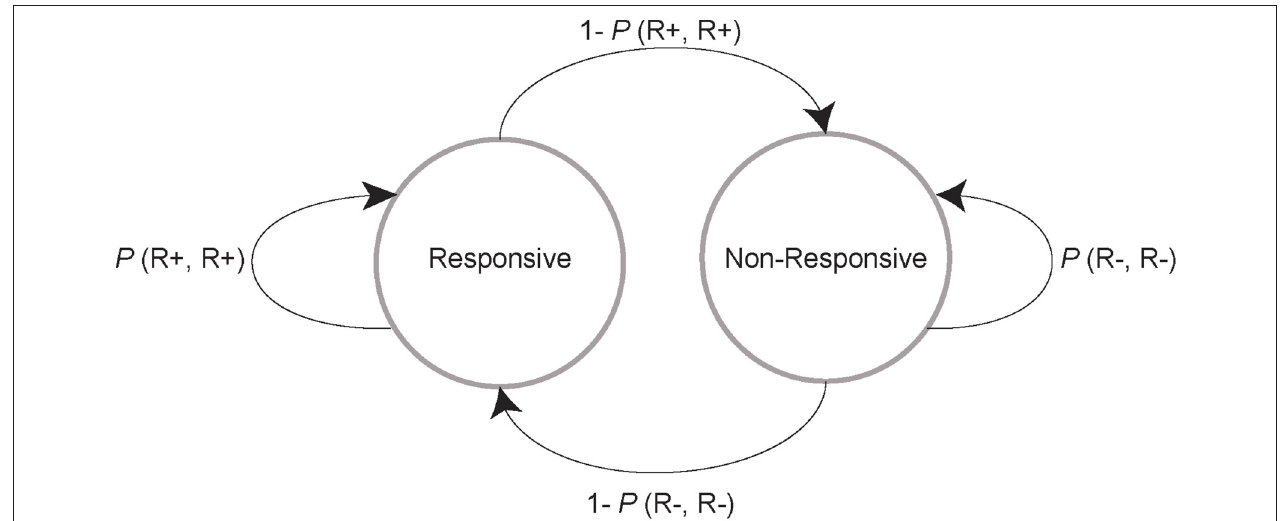
FIGURE 3 | Schematic of a two-state Markov model. On a given trial, a rat can either stay in the responsive (left circle and looping arrow) or non-responsive state (right circle and looping arrow) or transition to the other state (arrows between the circles). Each of these events occurs with a probability that is calculated by classifying all trials as those in which the animal responded (R + ) and did not respond (R − ), and then classifying the next trial in the same way. This procedure results in 4 possible categories for any consecutive pair of trials: R + ,R + ; R + ,R − ; R − ,R − ; and R − ,R + . The probability of the second trial outcome given the first is determined with the equation P (Response type 1 , Response type 2) = N (Response type 1 , Response type 2) / N (Response type 1) , where N is the number of trials. The 4 categories that describe the possible behaviors in any pair of trials form a stochastic matrix. We resolved this matrix into steady state probability vectors, which yield an estimate of the probability of finding each subject in either the responsive or non-responsive state at a steady state of the Markov